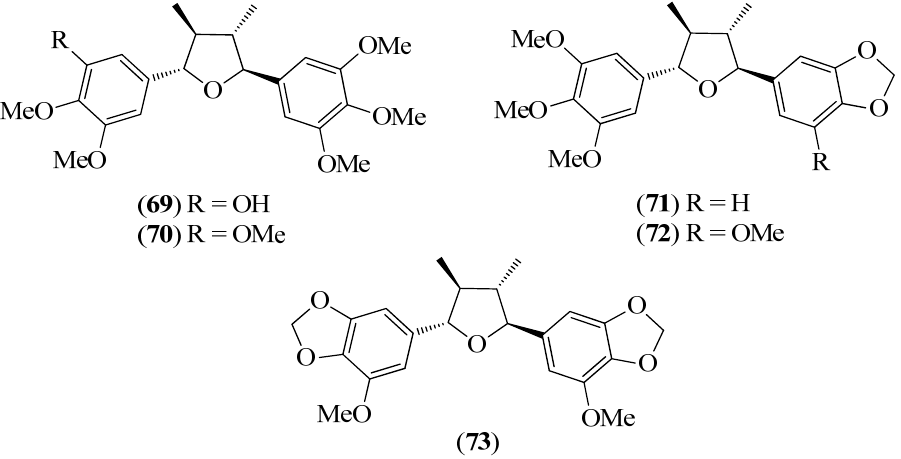
Figure 10. Structures of compounds 69 – 73 from Piper subscutatum .